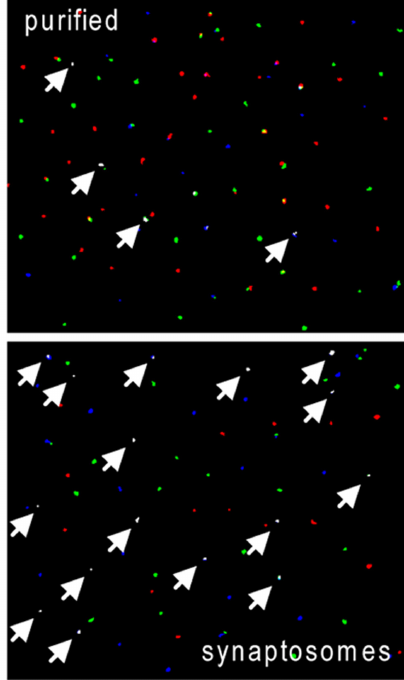
FIGURE 5. A 2A receptors in striatal synaptosomes and nerve terminals from rat striatum. Representative triple-labeling immunocytochemical colocalization of adenosine A 2A receptor (blue), D 1 receptor (red), and vGluT 1 (green) in synaptosomes and purified nerve terminals; in white, triple colocalization (arrows). There was a significantly higher triple expression of vGluT1 and A 2A and D 1 receptors in synaptosomes compared to purified nerve terminal preparations (see Table 1 and